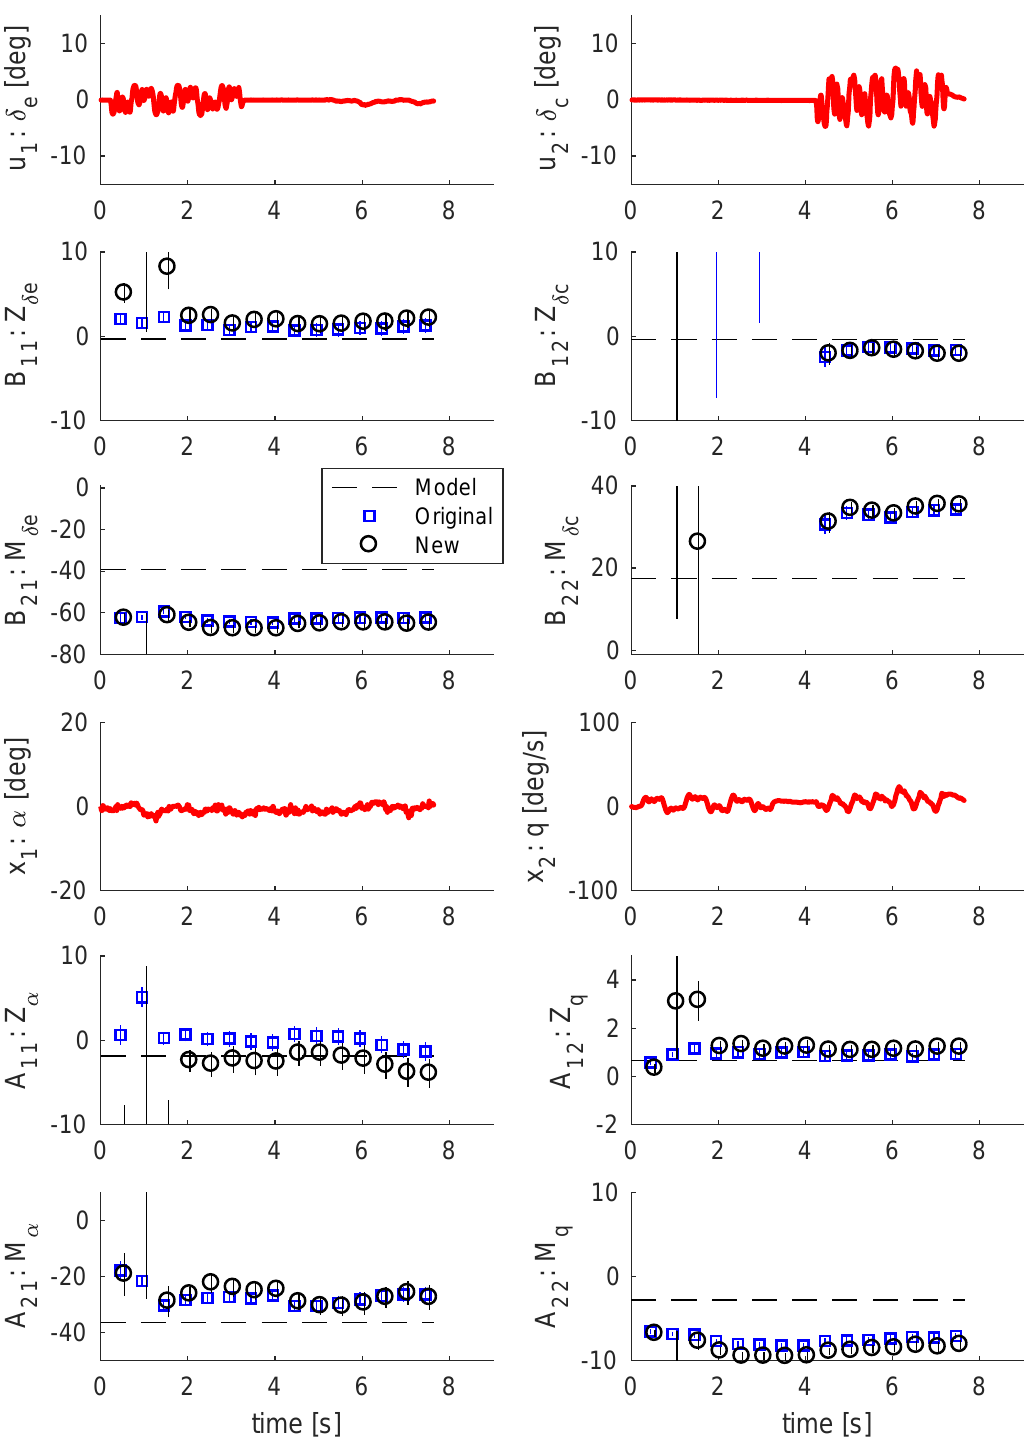
Figure 14. Results from flight FT. #2 with manoeuvre MSs1. The flight test data are shown in red, the results from the original method as blue squares and the results from the new method as black circles. The uncertainties are given as vertical bars. Note that the model (17) is not the true